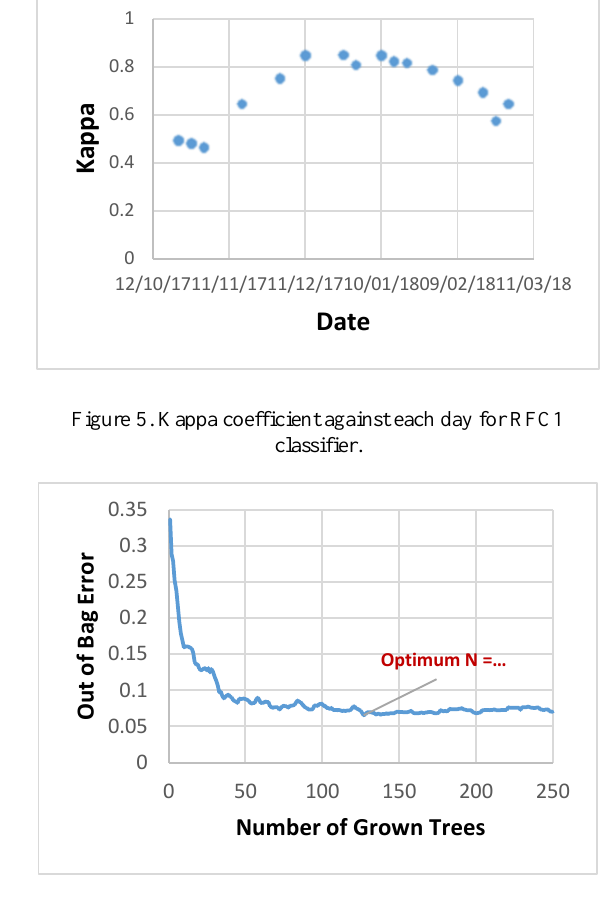
Figure 6. Progression of Out of Bag Error (OOBE) as the number of grown trees increases for classifier RFC1 6